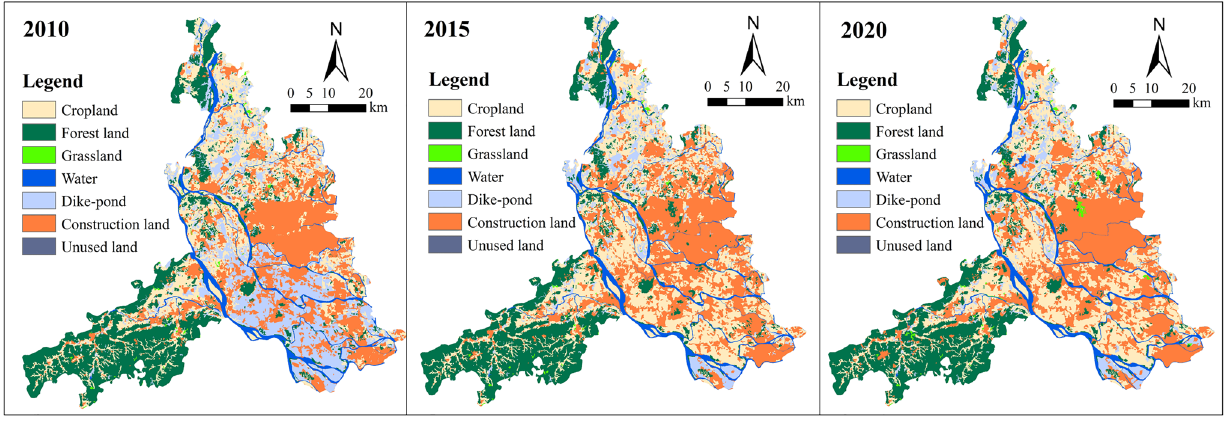
Fig.2 Foshan City’s land use in 2010, 2015, and